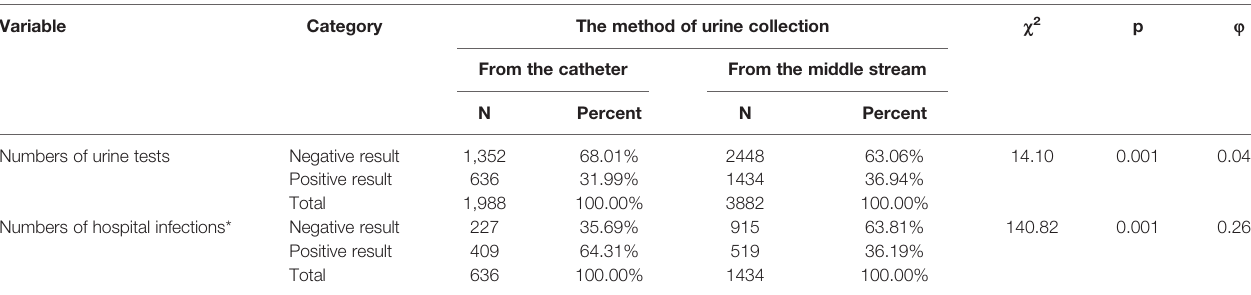
TABLE 3 | Urine test results in different urine collection methods.